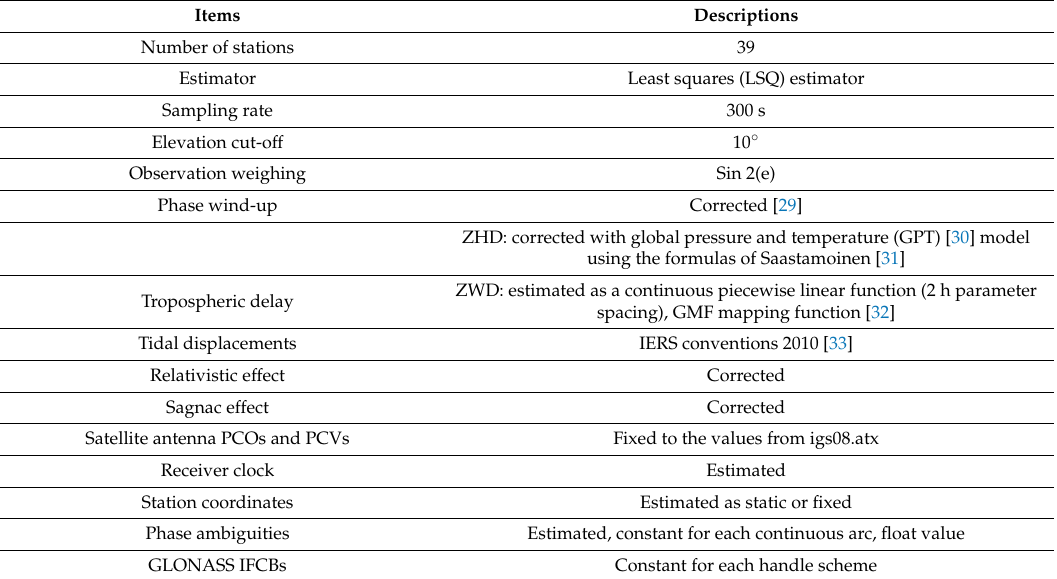
Table 4. Summary of GPS- and GLONASS-PPP processing strategies.